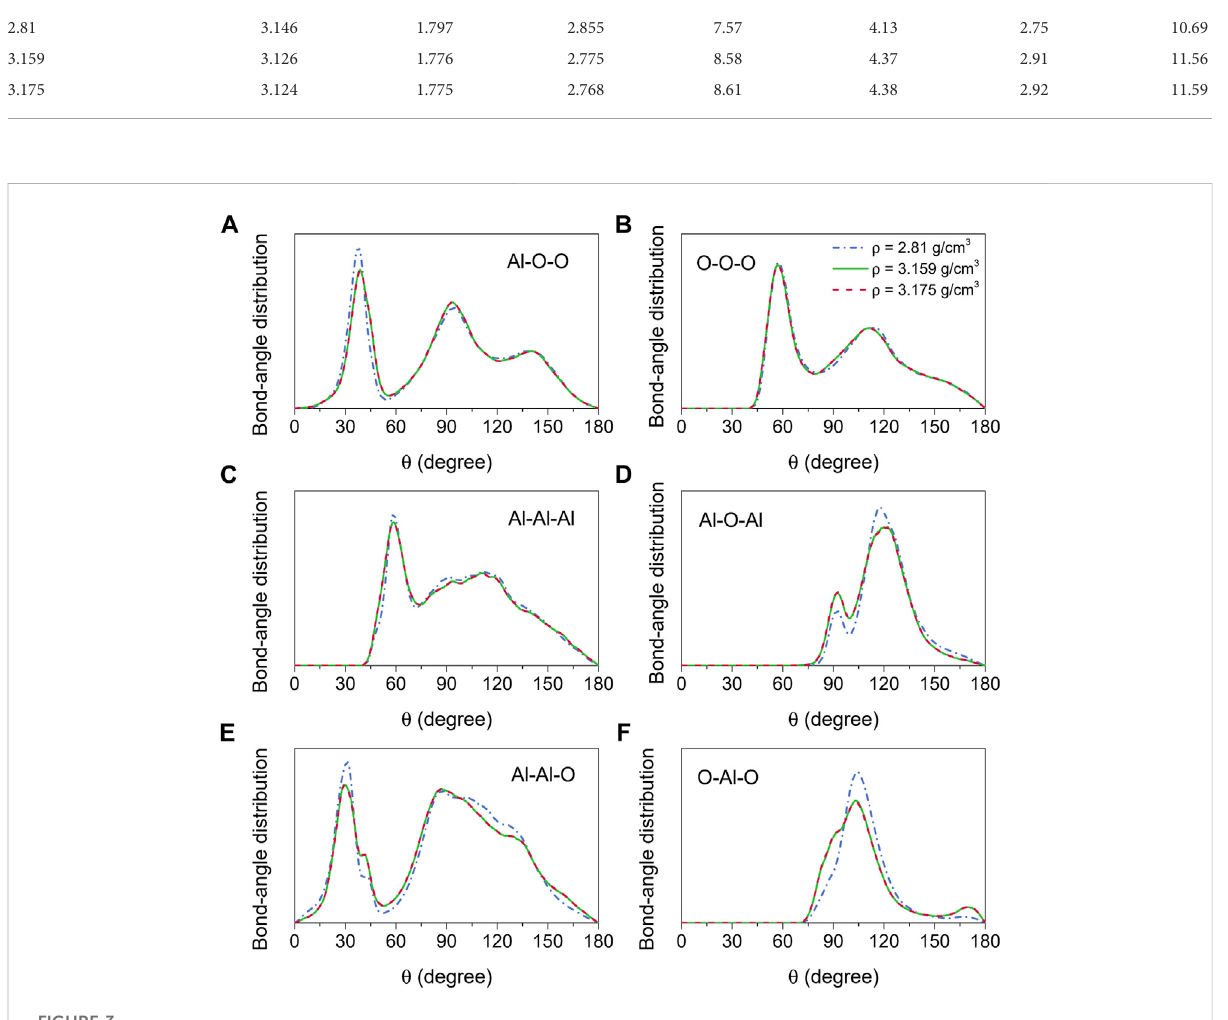
FIGURE 3 Bond-angle distributions foramorphousalumina at300 Kandthree densities, (A) Al-O-O, (B) O-O-O, (C) Al-Al-Al, (D) Al-O-Al, (E) Al-Al-O and (F)